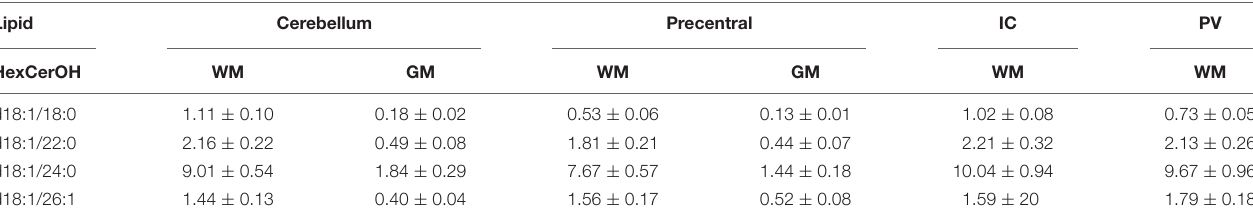
TABLE 4 | Levels of hydroxy hexosyl ceramide (HexCerOH) in regions of the formalin fixed human brain ( n = 21): cortical gray matter (GM) of the cerebellum, white matter (WM) of the superior cerebellar peduncle, cortical gray and subcortical white matter of the precentral gyrus, internal capsule (IC) and periventricular (PV) white matter. Lipid Cerebellum Precentral IC PV